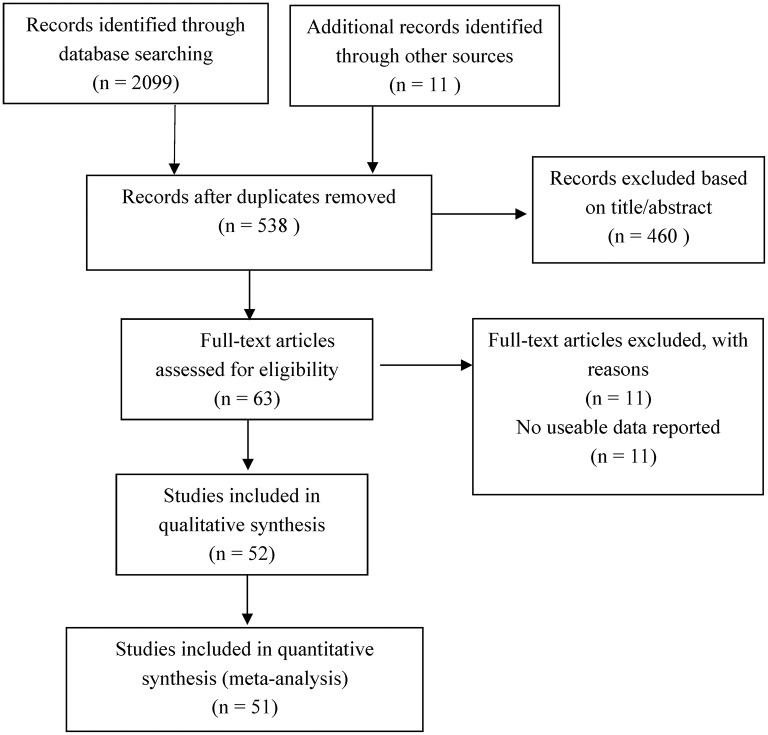
PRISMA flow diagram.